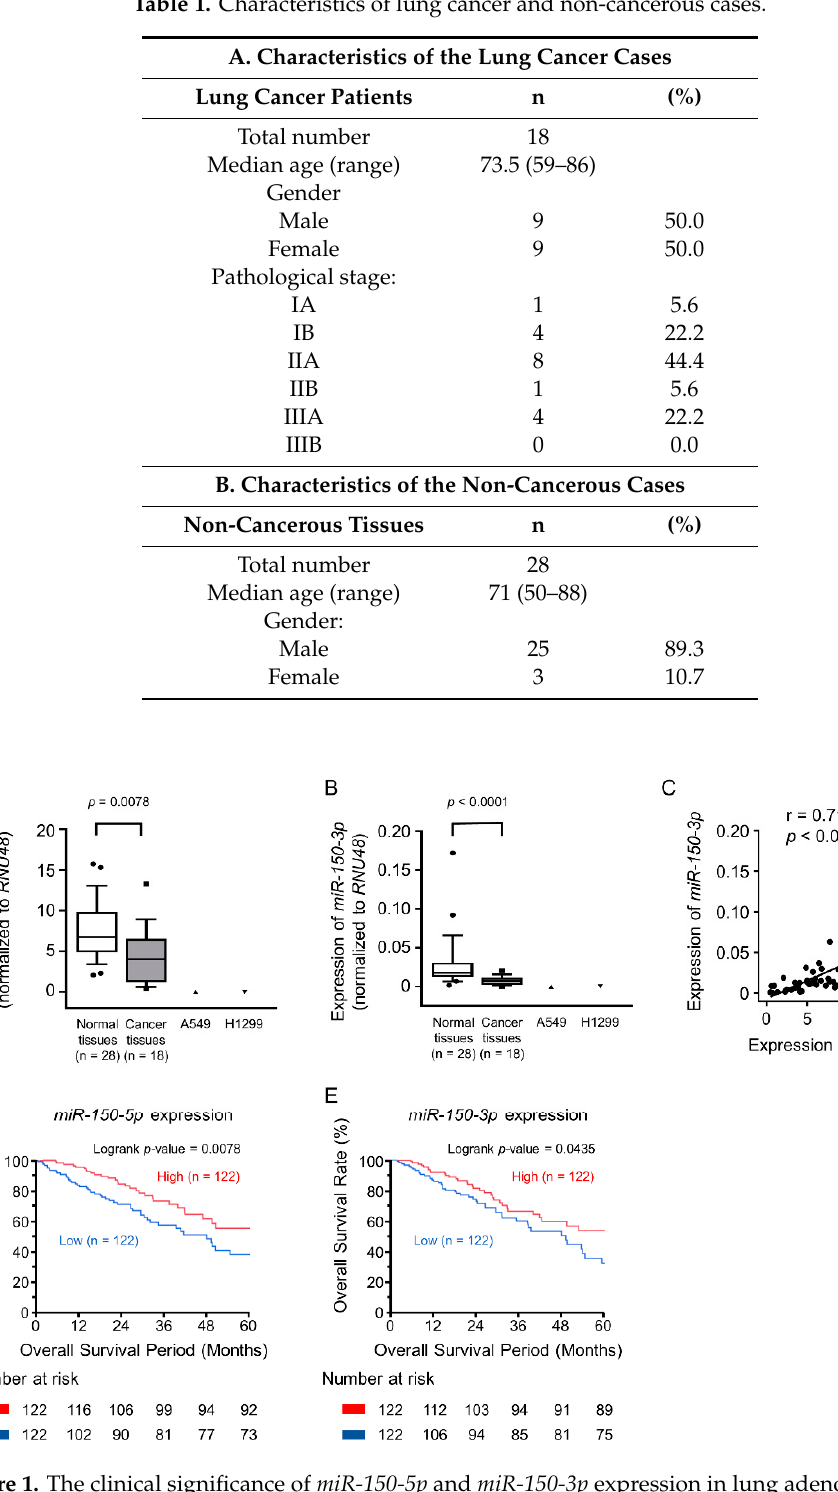
Figure 1. The clinical significance of miR-150-5p and miR-150-3p expression in lung adenocarcinoma (LUAD). ( A , B ) Downregulation of miR-150-5p and miR-150-3p expression in clinical specimens of LUAD and two cell lines (A549 and H1299). Expression of RNU48 was used as an internal control. ( C ) Expression of two miRNAs derived from miR-150 -duplex were positive correlation by Spearman’s rank test. ( D , E ) The Kaplan–Meier overall survival curve analyses of patients with LUAD by The Cancer Genome Atlas (TCGA) database. Patients were divided into two groups according to miRNA expression and analyzed.